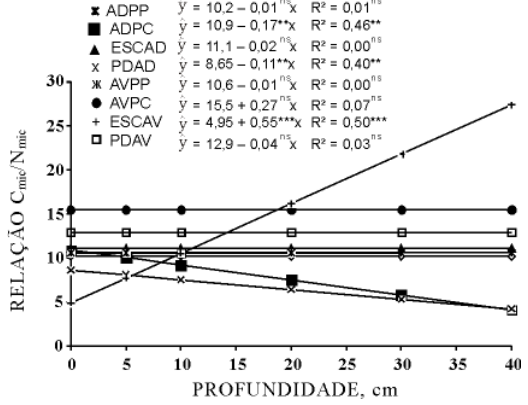
:N de acordo mic mic